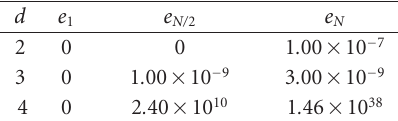
Table 6.1. Approximate error for Example 6.1.